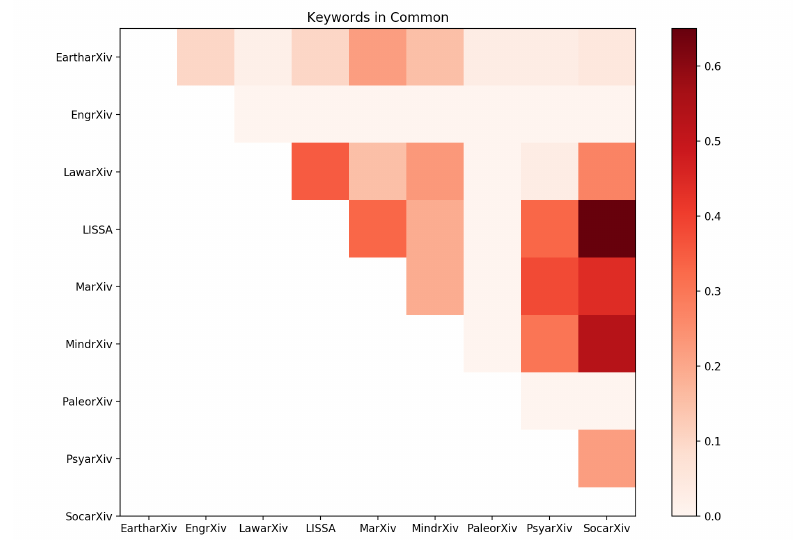
Figure 5. The Szymkiewicz-Simpson overlap coefficient for each pairwise comparison with 0 indicating no overlap and 1 indicating the smaller set of keywords is a subset of the larger